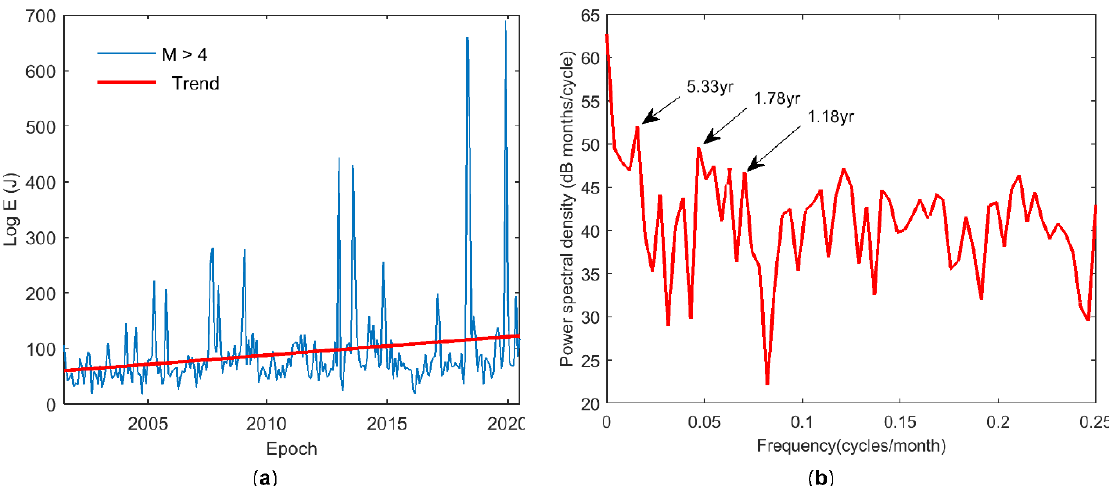
Figure 6. ( a ) Monthly time series of the earthquakes’ energy, including the linear trend. Periodic components appear to be present as well. ( b ) The earthquake time series periodogram contains periodic components of 5.33, 1.78, and 1.18 years.